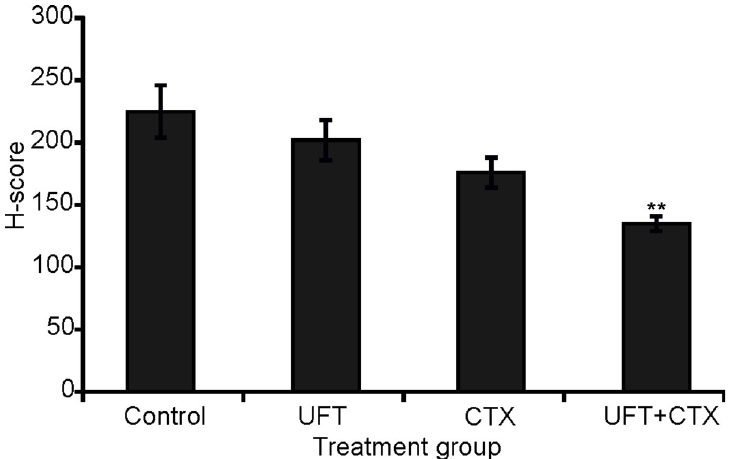
Fig 8. Immunohistochemistry for p-Met[Y1003] H-score results. There was a statistically significant decrease in the expression of p-Met[Y1003] in the UFT+CTX treated group, compared to untreated control (Student´s t test, 0.009576 two-tailed